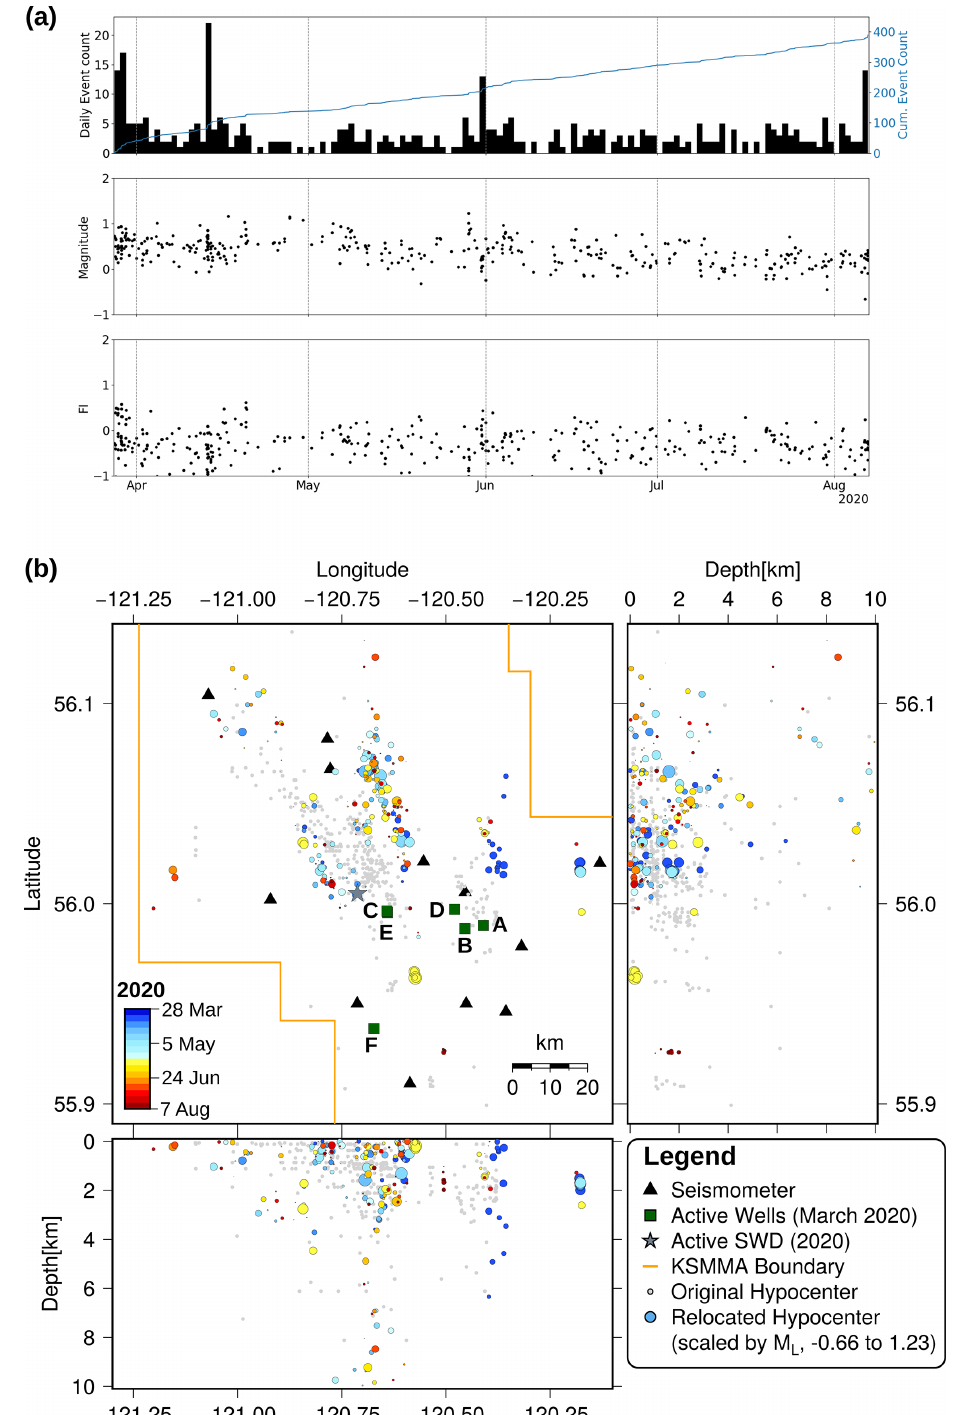
Figure 5. Temporal and spatial evolution of 389 events detected in the KSMMA during the cessation of almost all operations from April to August 2020. (a) Upper : daily event count and cumulative event counts. Middle : M L determined using the formula of Babaie-Mahani and Kao (2020). Lower : Frequency index (FI) detailing the ratio of high-frequency energy to low-frequency energy within each detected waveform at KSM06. (b) Spatial evolution of events coloured by time and scaled by magnitude. Active wells that initiated seismicity in the month prior to quiescence (March 2020) are shown as green squares labelled A (most recently active prior to lockdown, i.e. late March 2020) to F (active in early March); one active SWD well is shown as the grey star. Figure generated using GMT v.6 (Wessel et al., 2019).